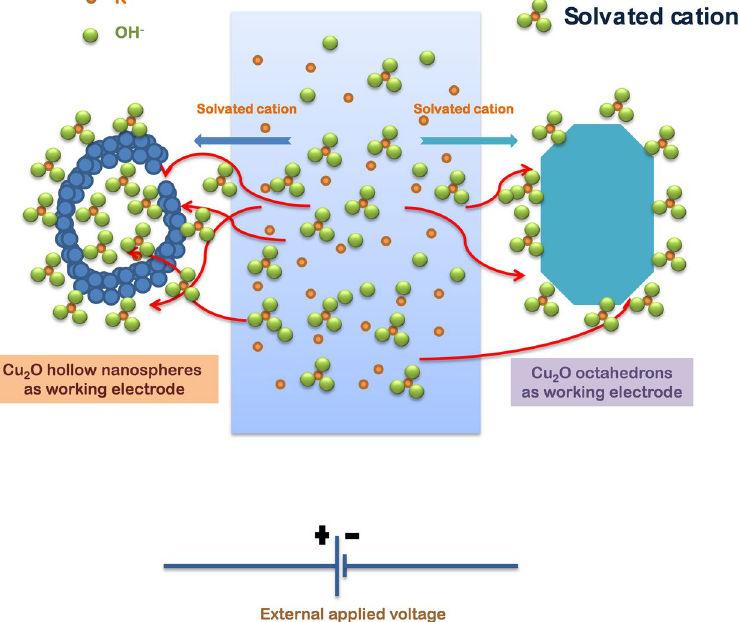
Figure 5. Schematic scheme of the ion interaction with electrode for Cu(HN) and Cu(OCT) as electrode